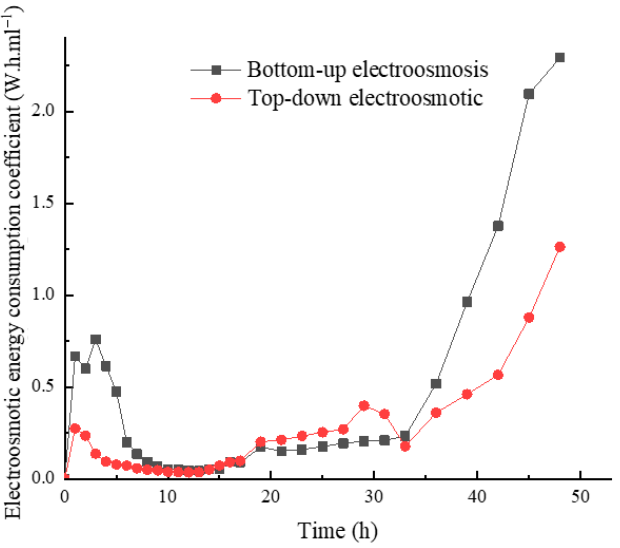
Figure 15. Curve of electro-osmosis energy consumption coefficient with time.